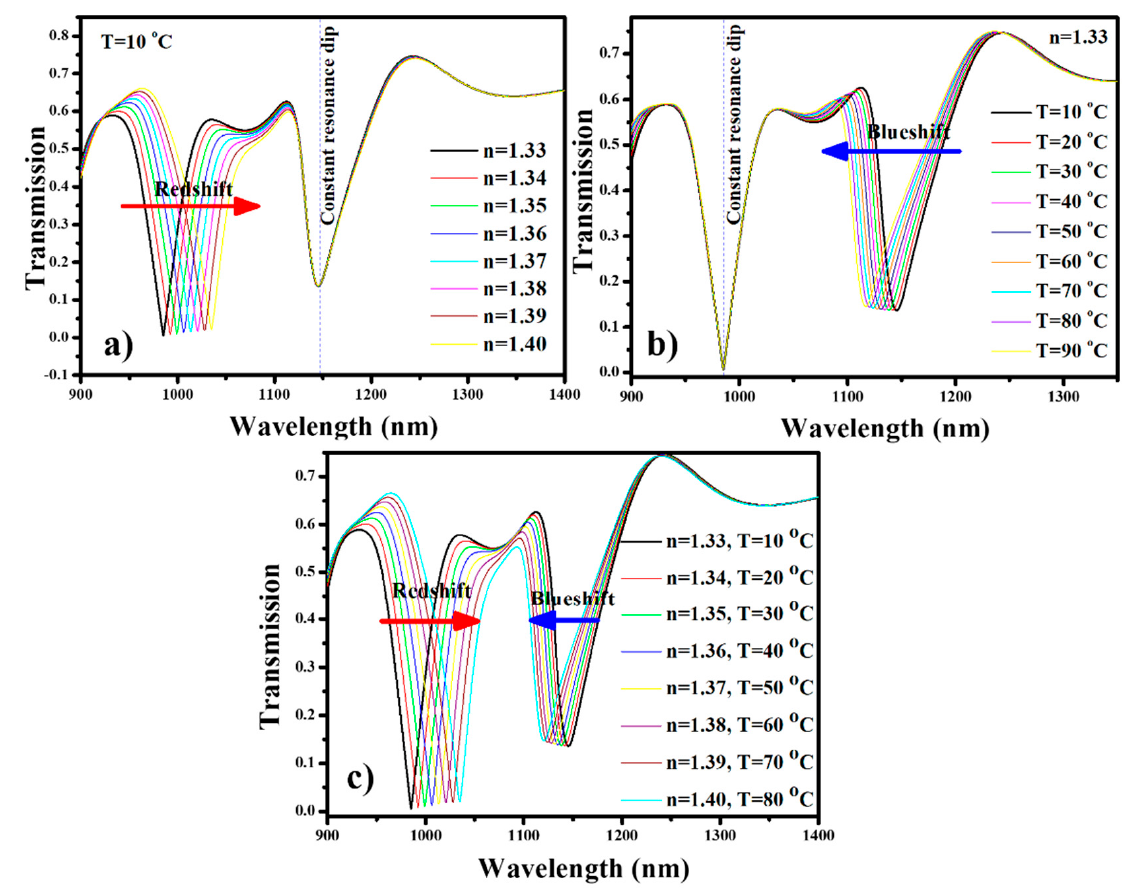
Figure 7. Transmission spectrum of the sensing device when employed as ( a ) biosensor, ( b ) temperature sensor, and ( c ) biosensor and temperature sensor.